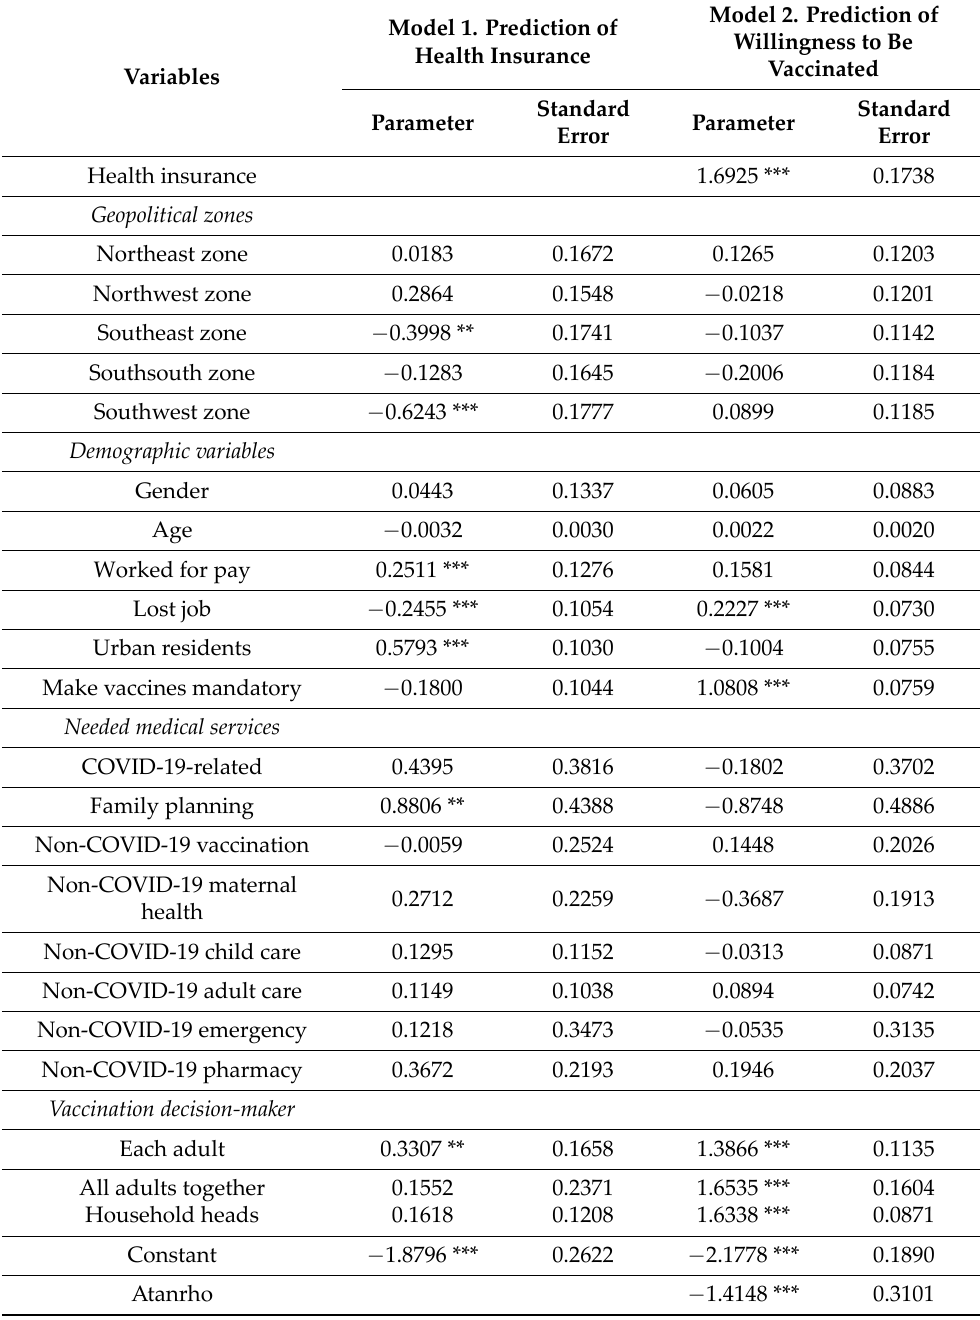
Table 3. Parameters of the recursively estimated probit